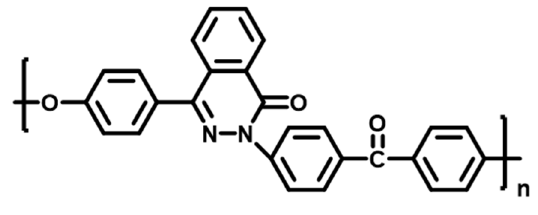
Figure 1. Molecular structure of